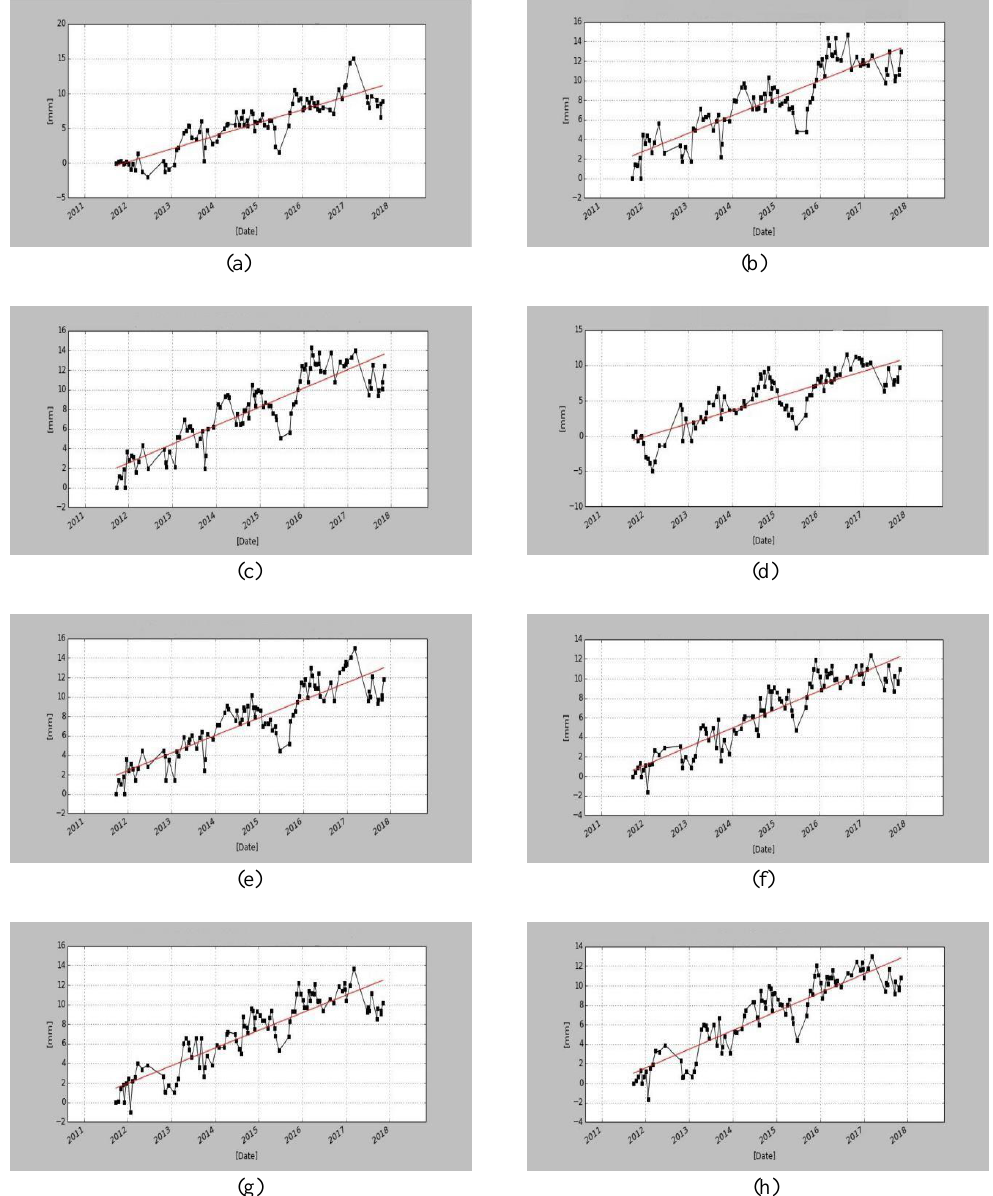
Figure 7. Study area selection PS point deformation information line diagram (a)3ECF0 deformation line diagram; (b)43B86 deformation line diagram; (c)43B87 deformation line diagram; (d)449BB deformation line diagram; (e)4426B deformation line diagram; (f)40185 deformation line diagram; (g)40861 deformation line diagram; (h)40862 deformation line